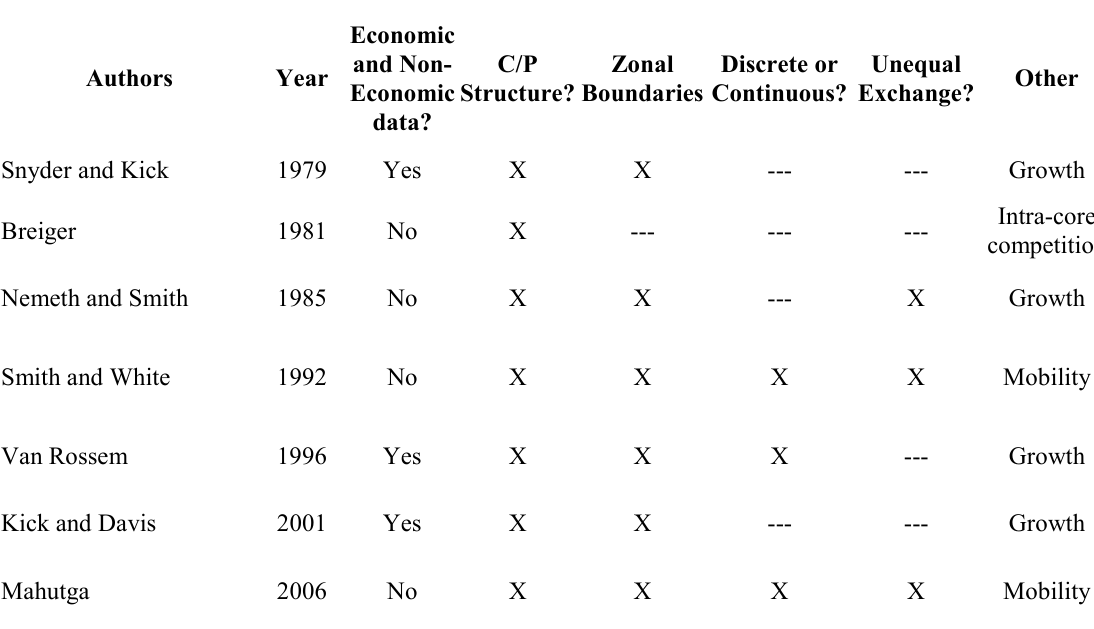
Table 2: Major Articles Reviewed